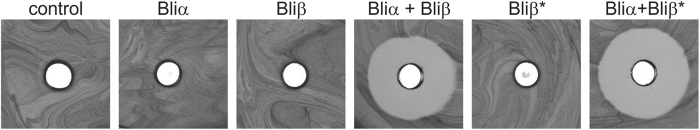
Antimicrobial activity of lichenicidin peptides.Bliα. Bliβ and
Bliβ([3,2]Tpa9), indicated as
Bliβ*, were tested separately (concentration
0.5 μM) and in equimolar (1:1) combinations against
the indicator strain Micrococcus luteus (DSM-1790). The assay was
performed in triplicate.